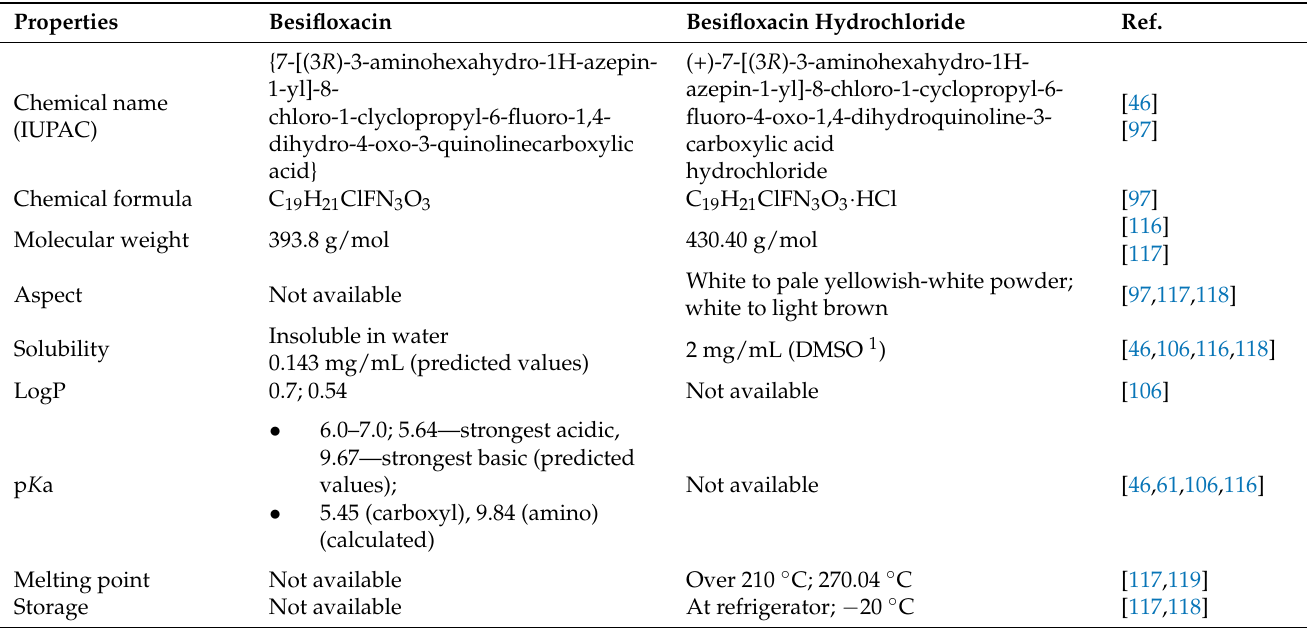
Table 3. Physicochemical properties of